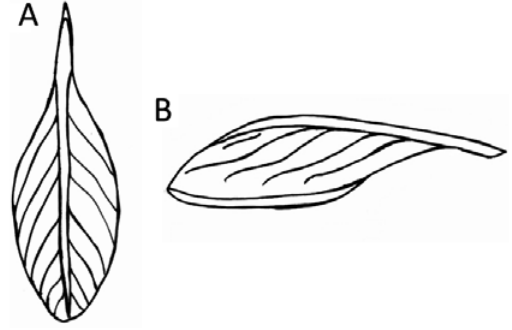
Figure 4 - Dorsal and lateral aspects of gladius of Lolliguncula brevis